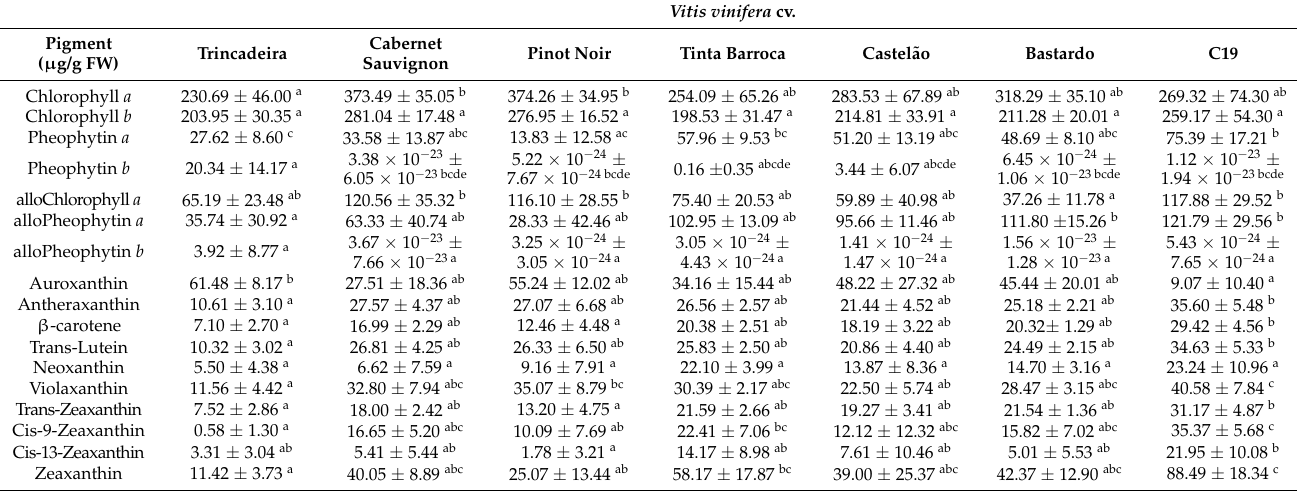
Table 2. Average concentration and standard deviation of each pigment in grapevine leaves. N = 5, for a given row, different letters indicate significant differences at p < 0.05; same letters indicate no significant differences ( p > 0.05) (Kruskal–Wallis